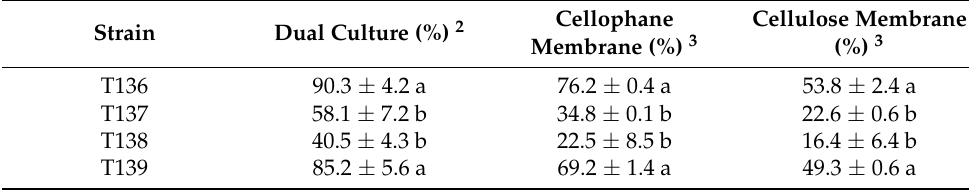
Table 2. Inhibition of Fusarium graminearum ( Fg ) colony growth by four Trichoderma strains